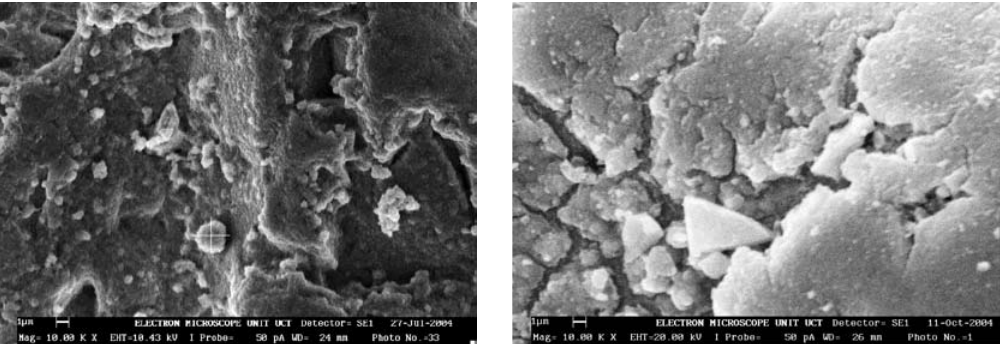
Fig. 6 SEM micrographs of silica grain showing the surface texture for 2FP (left) and 6FP